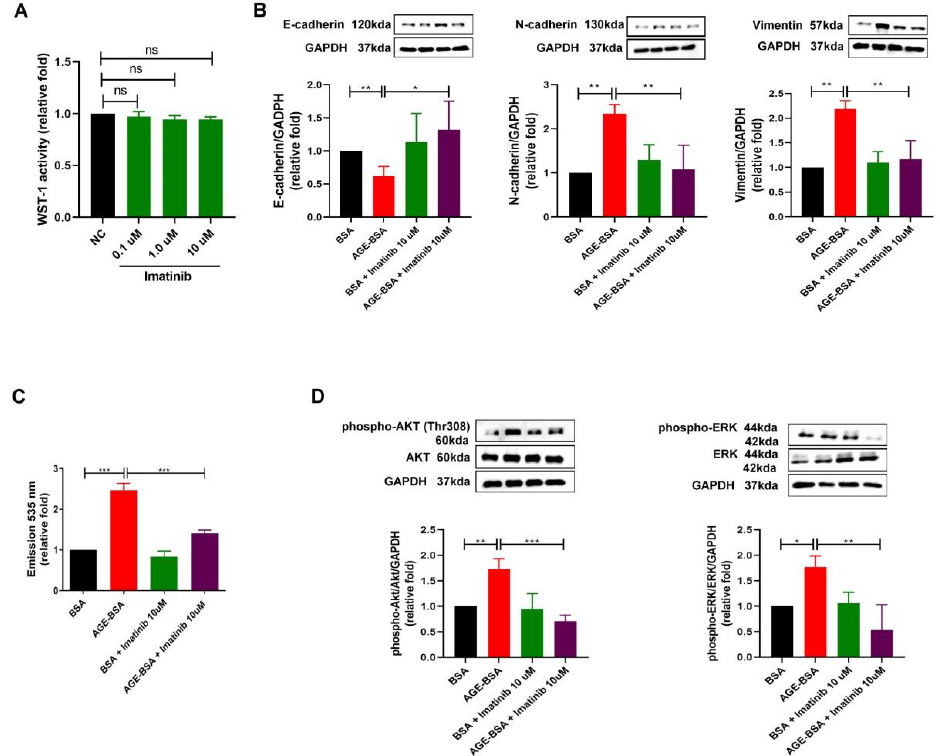
Figure 4. Imatinib rescued the glomerular endothelial injury induced by AGEs in HGECs. ( A )